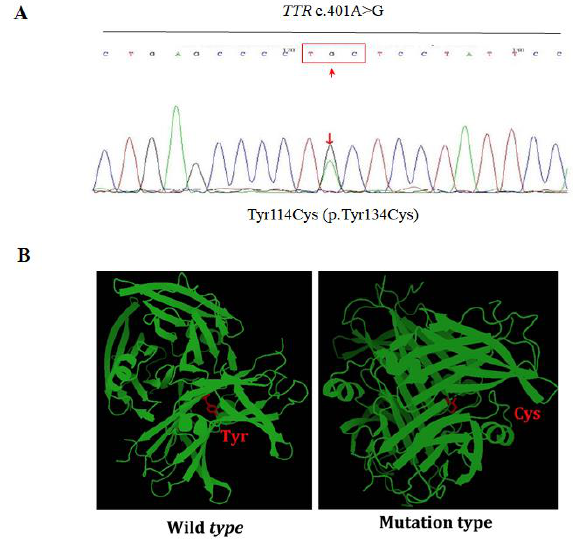
Figure 8. Genetic Analysis of the Mutation TTR c.401A>G (p.Tyr134Cys). ( A ) Representative image of genetic sequencing of TTR in all five cases, indicating transversion of adenosine to guanine at position 401, which resulted in substitution of tyrosine with cysteine at position 114 of exon 4. ( B ) Comparison of the three-dimension structures of wildtype and mutation type (Tyr114Cys) of TTR generated by PyMOL.